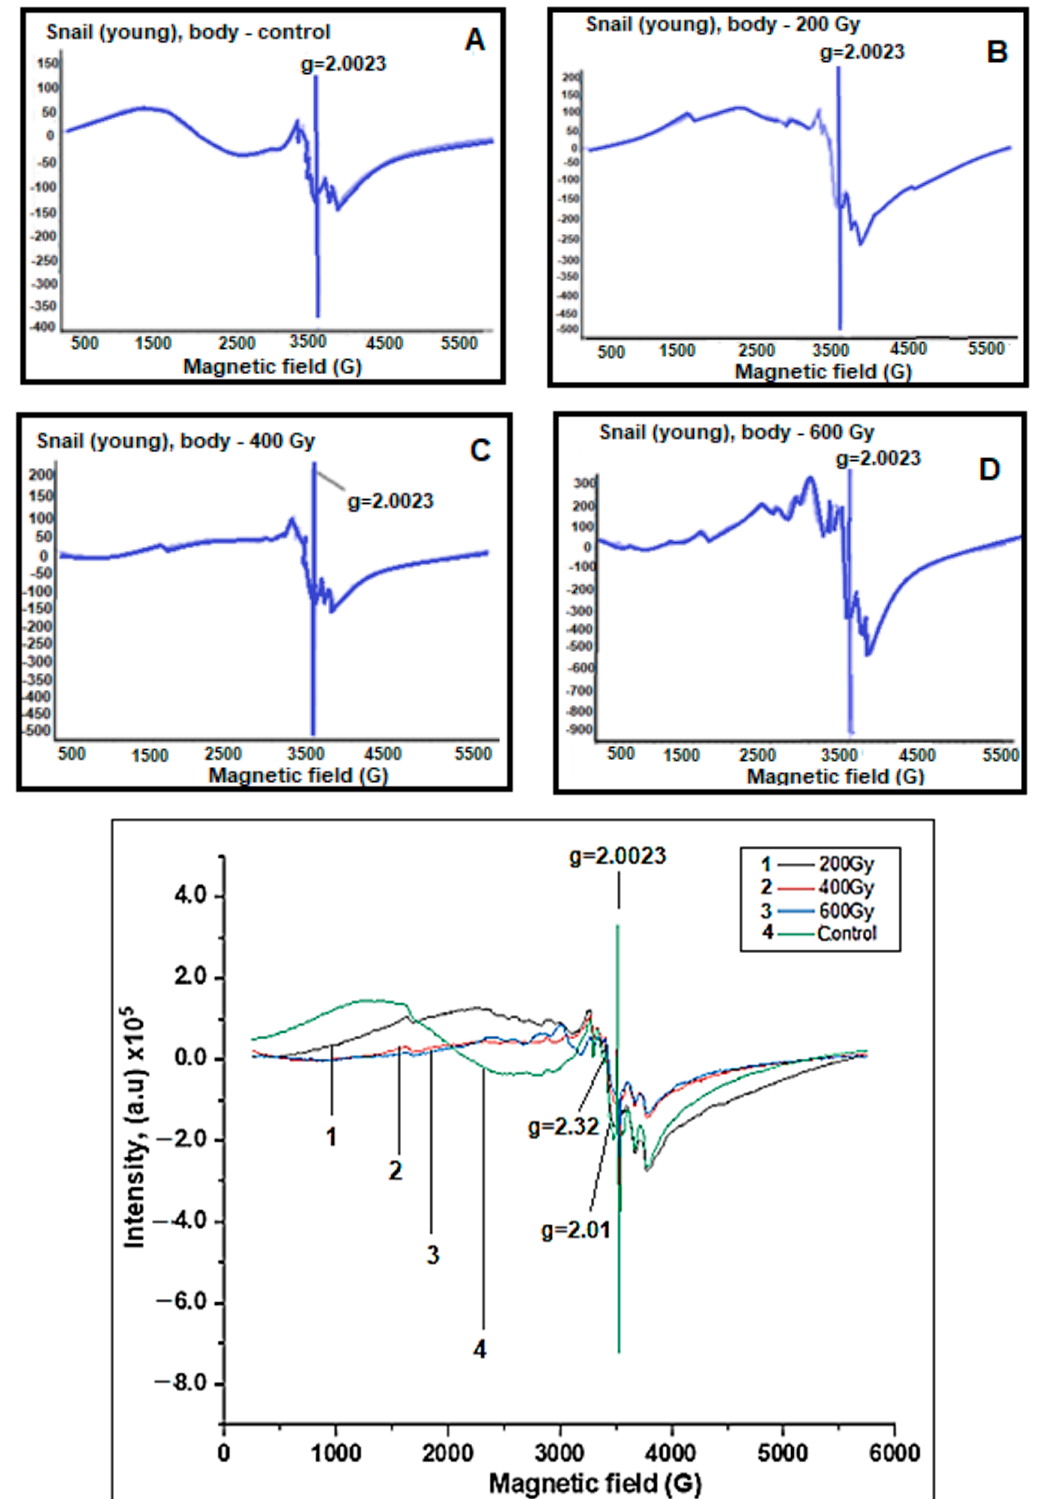
Figure 3. EPR spectra of body parts of the control and irradiated at different doses of young grape